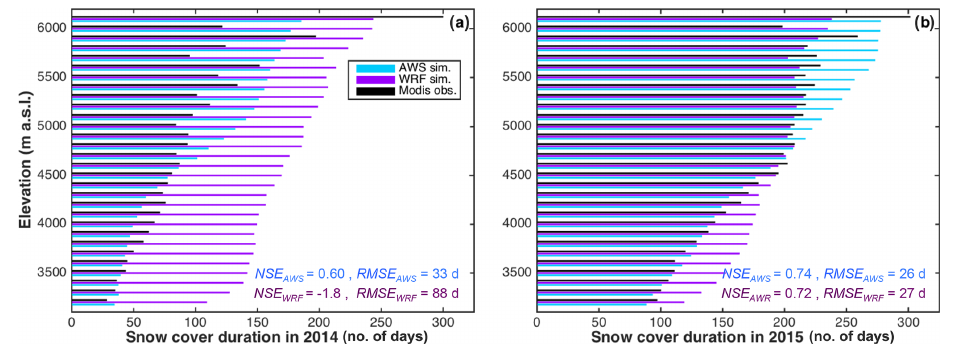
Figure 7. Snow cover duration per 200m elevation band, from MODIS images (black), AWS forcing (blue) and WRF forcing (purple) for (a) 2014 and (b)